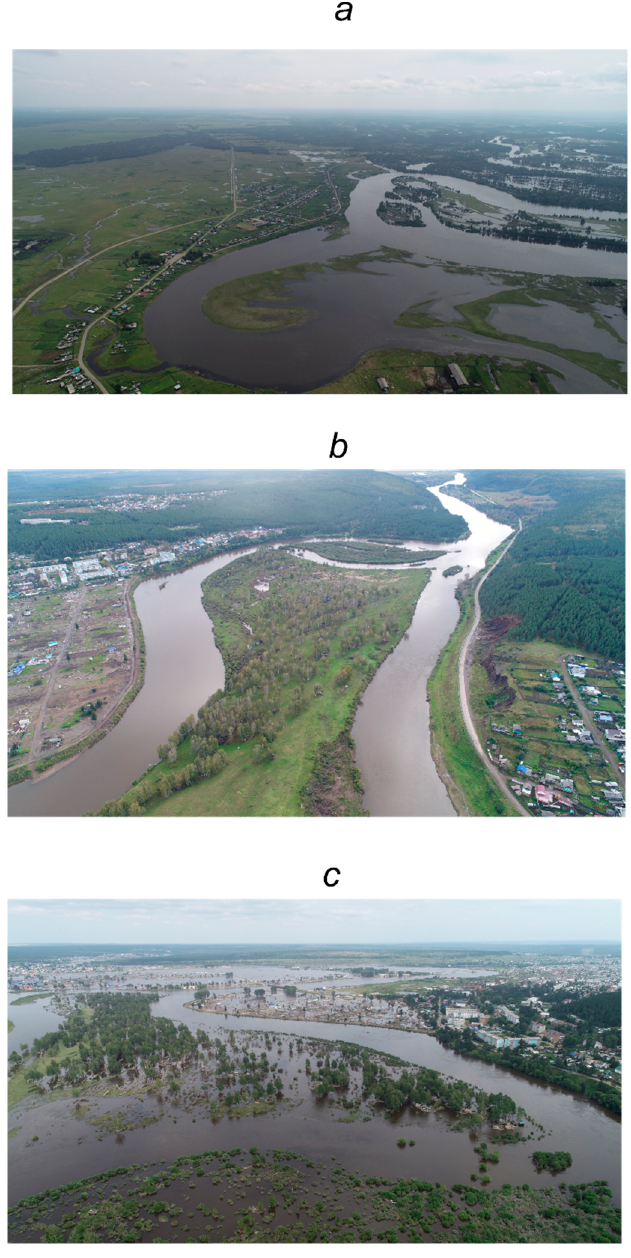
Figure 6. Impacts of floods on the IyaRiver: ( a )—flooding of the wide floodplain section of the valley in the vicinity of Tulun; ( b )—consequences of bank erosion; ( с )—processes of bank destruction and landslides (area of the gauging station in Tulun). Survey coordinates: 54°24 ′ 27.4218 ″ N, 100°43 ′ 23.1820 ″ E. Shooting: 2 August 2019.